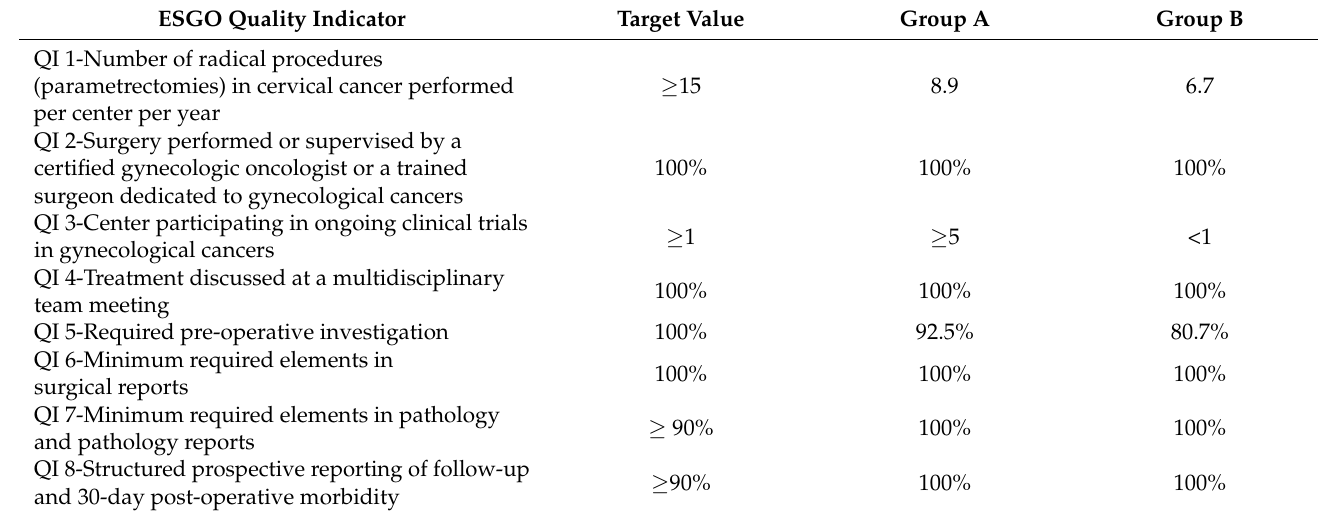
Table 3. ESGO quality indicators related to the treatment of cervical cancer .